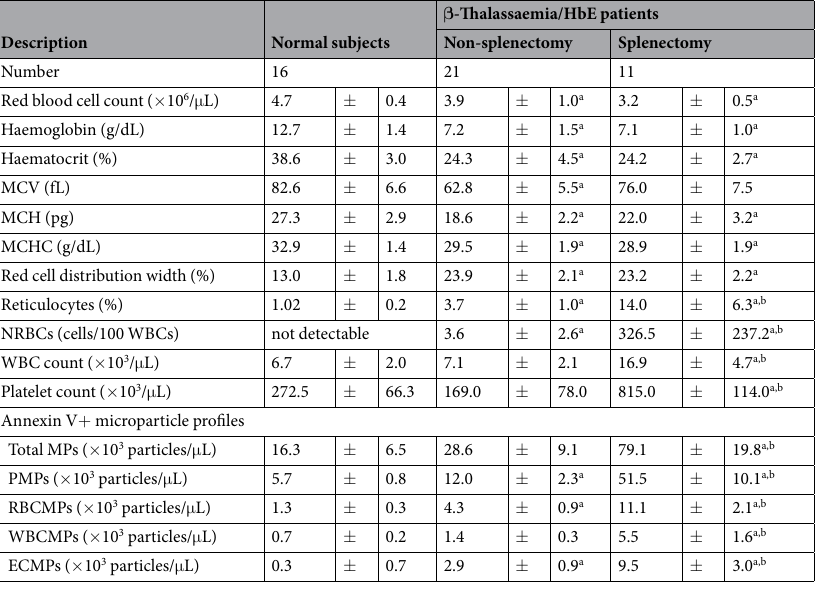
Table 1. Haematological parameters and microparticle profiles. ECMPs; endothelial cell-derived MPs, MCV; mean corpuscular volume, MCH; mean corpuscular haemoglobin, MCHC; mean corpuscular haemoglobin concentration, MPs; microparticles, NRBCs; nucleated red blood cells, PMPs; platelet-derived MPs, RBCMPs; RBC-derived MPs, WBCs; white blood cells and WBCMPs; WBC-derived MPs. a Significant difference when compared to normal subjects at P < 0.05. b Significant difference when compared to non-splenectomised β -thalassaemia/HbE patients at P <